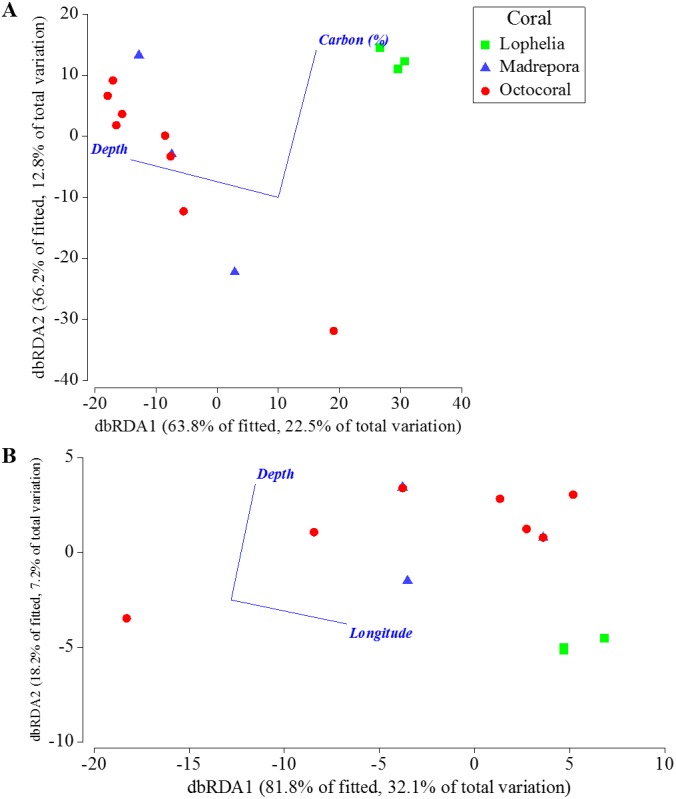
Distance-based redundancy analysis of the best two-variable model from distance-based linear modeling of sampling locations near coral habitats where sediment geochemistry data were available.(A) Based on Bray–Curtis similarities of square-root transformed abundance data averaged for individual sampling locations. (B) Based on Bray–Curtis similarities of square-root transformed functional trait weighted abundances averaged for individual sampling locations.